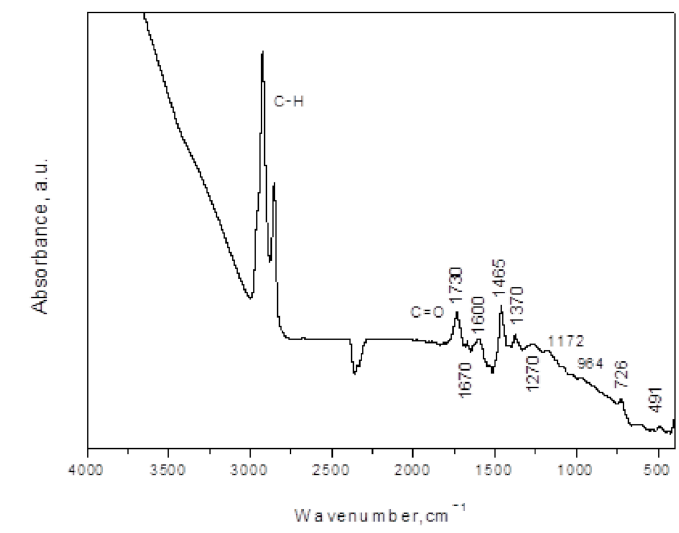
Figure 5. FTIR spectra of carbon